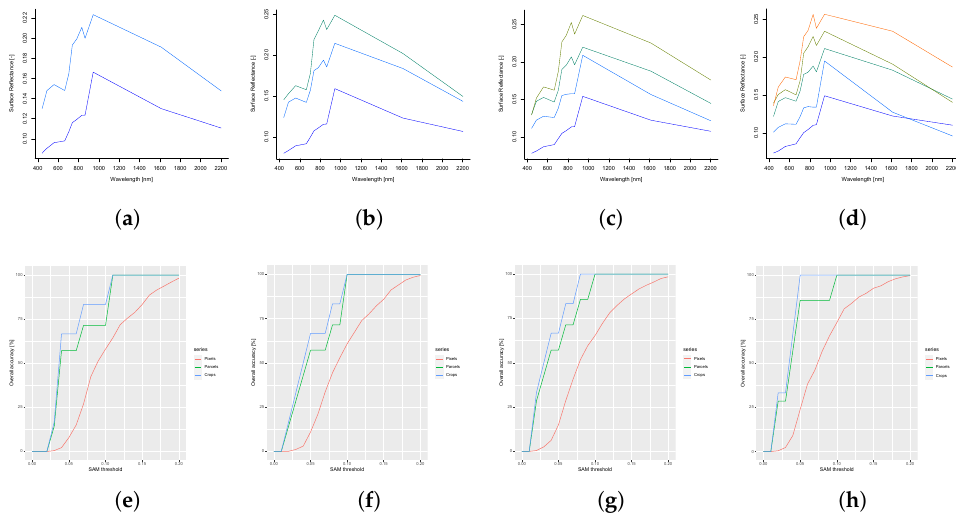
Figure 13. Non-plastic greenhouses: the end-members (EMs) with the use of different intervals of || r || and the resulting overall SAM-based classification accuracy. ( a ) 2 EMs: spectra, ( b ) 3 EMs: spectra, ( c ) 4 EMs: spectra, ( d ) 5 EMs: spectra, ( e ) 2 EMs: accuracy, ( f ) 3 EMs: accuracy, ( g ) 4 EMs: accuracy, ( h ) 5 EMs: accuracy.